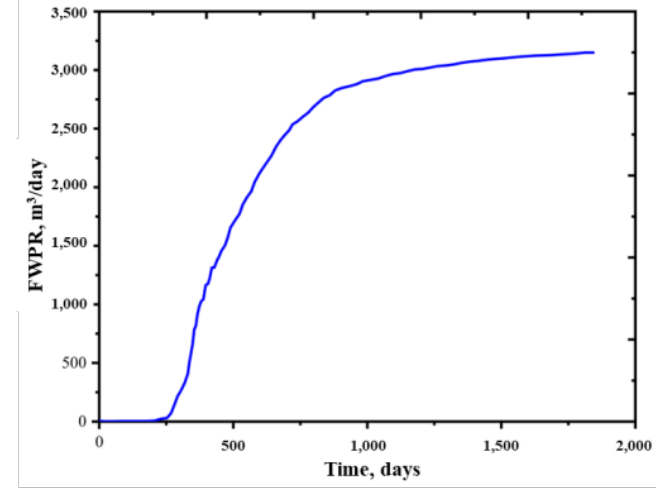
Figure 24. Field water cut for vertical wells.